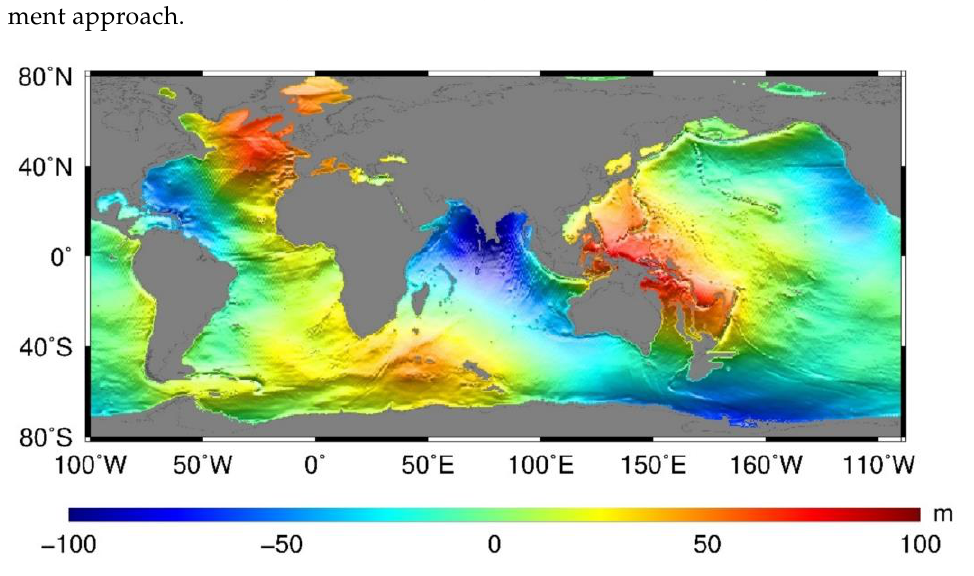
Figure 3. Mean sea surface model in the oceanic region.